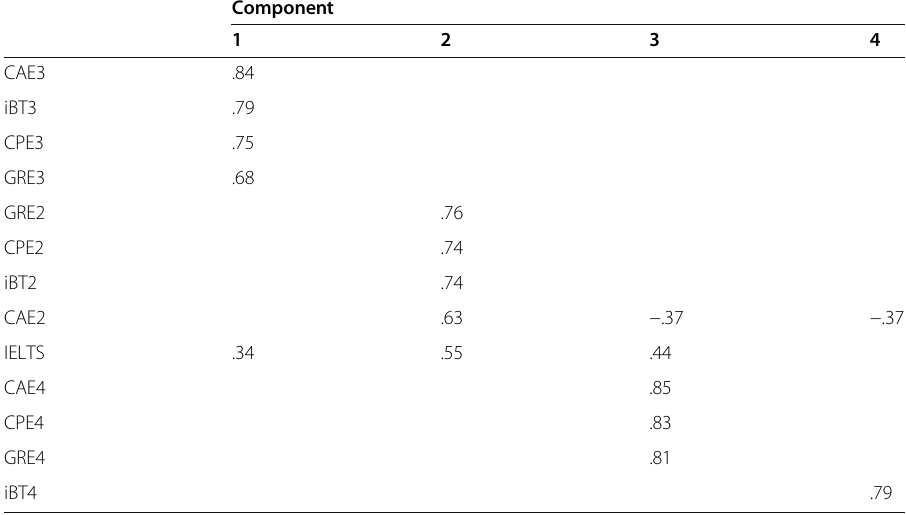
Table 10 Rotated component matrix a (Rater 1